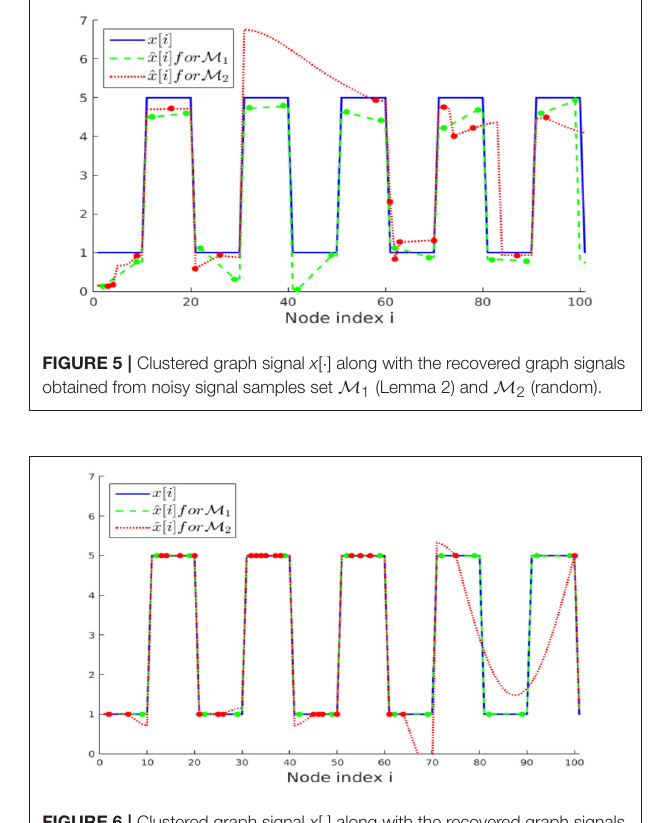
FIGURE 6 | Clustered graph signal x [ · ] along with the recovered graph signals obtained from noiseless signal samples over sampling set M 1 (Lemma 2) and M 2 (random). The noiseless signal samples y [ i ] = x [ i ] are marked with